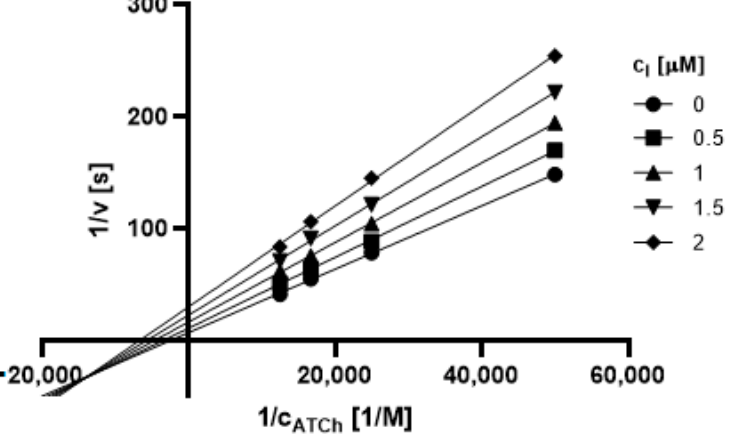
Figure 8. Lineweaver–Burk plot for 1n and AChE inhibition (ATCh = acetylthiocholine).